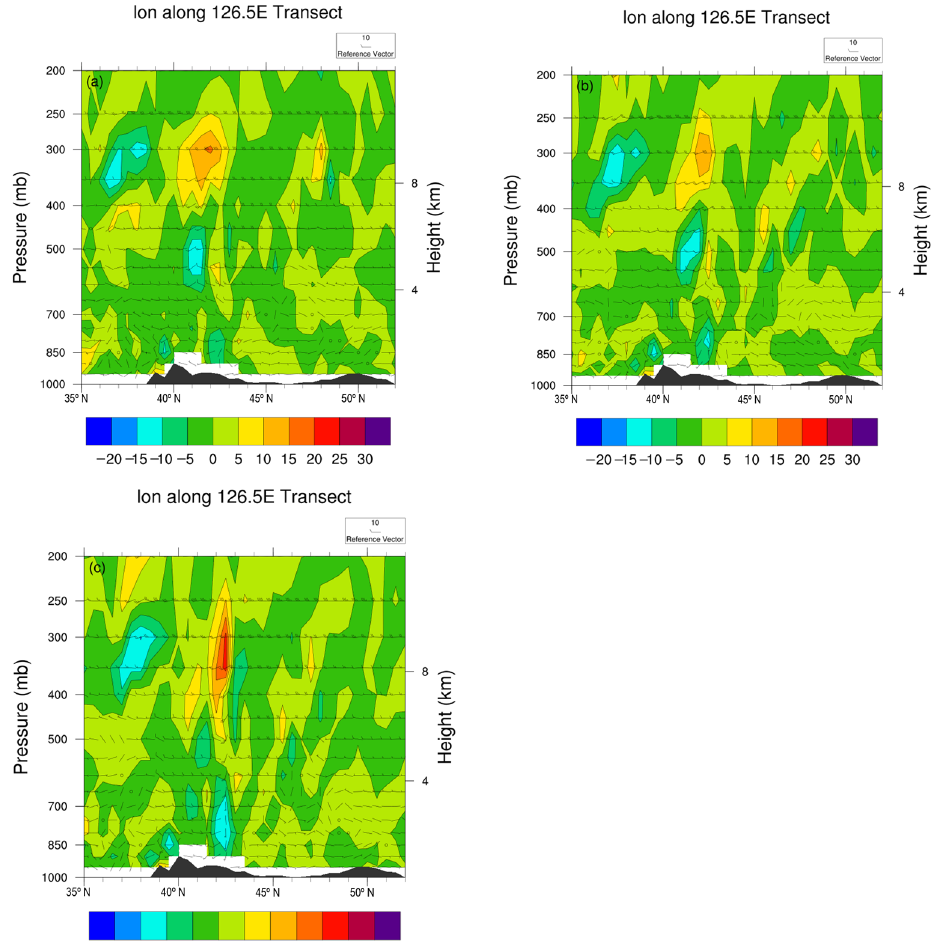
Figure 12. vertical profile of the resultant wind (Plume) along longitude 126.5 ◦ E divergence (shaded, unit: 10 − 5 s − 1 ), v and w * 20 (barbs; m/s) at ( a ) 19 ( b ) 20 ( c ) 21 UTC on 14 August